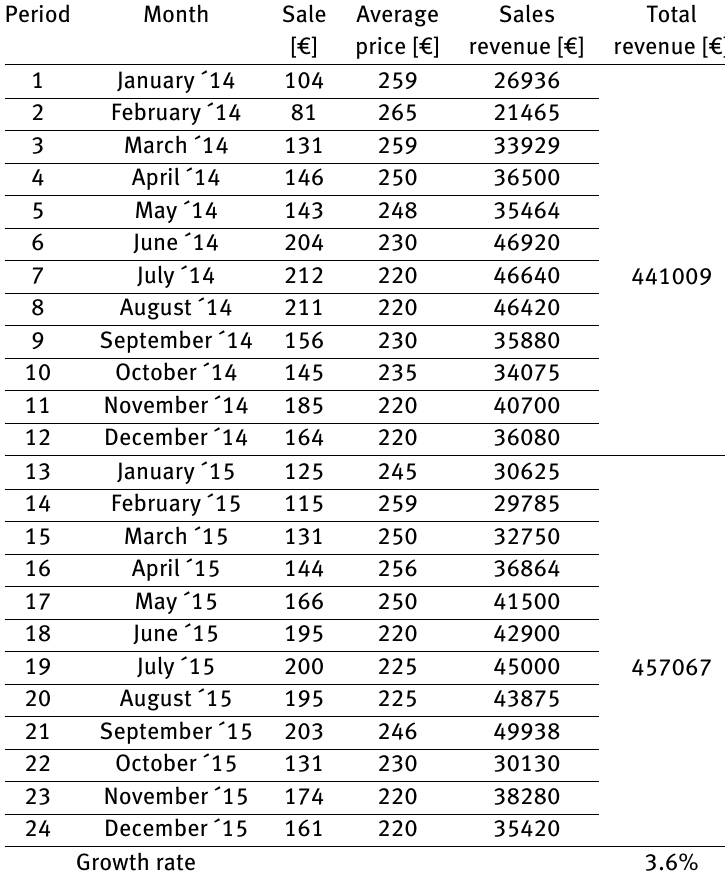
Table 1: Input data about the sale, monthly average prices and revenues.